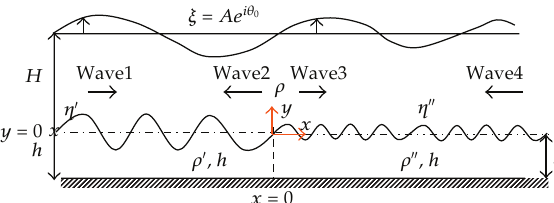
Figure 2: Configuration of the problem in the two-layer system with two muddy